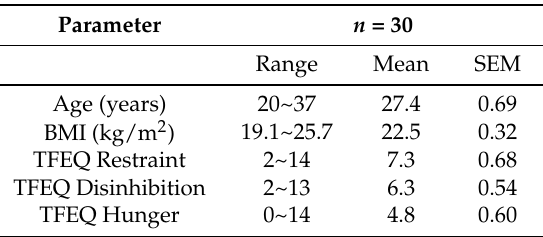
Table 1. Participants’